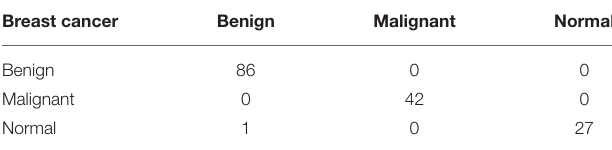
TABLE 9 | Confusion matrix of dataset “A” (testing). TABLE 10 | Confusion matrix of dataset B (testing).